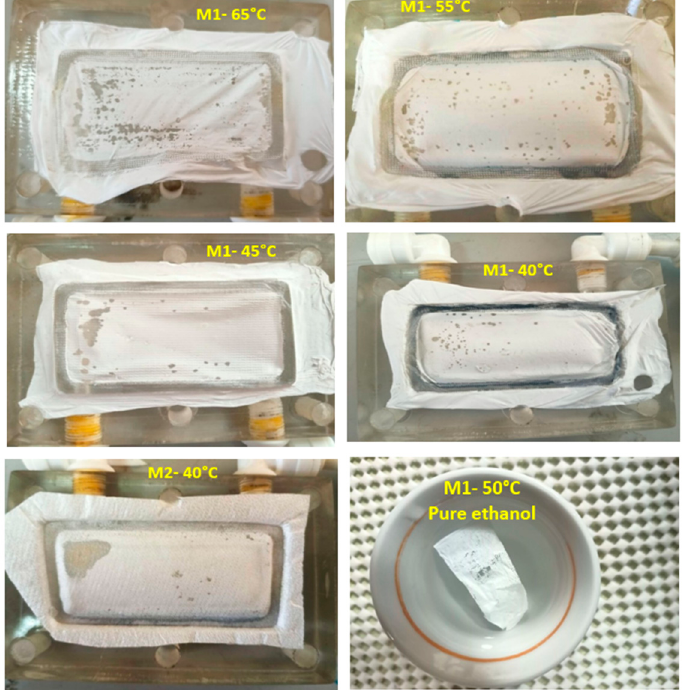
Figure 2. Pictures of the failure of the two types of PTFE membranes (M1 and M2) for a 2 wt.% initial ethanol concentration at 40–65 °C feed temperature, a 0.6 L/min feed flow rate, and 79.9 mbar permeate vacuum pressure.